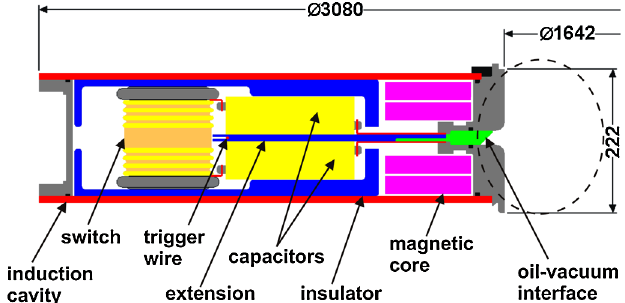
FIG. 1. (Color) Design of the 1-MA LTD stage showing two storage capacitors, the switch and the buses of the brick. Broken ellipse indicates the region of the load location and is presented in more detail in Fig.